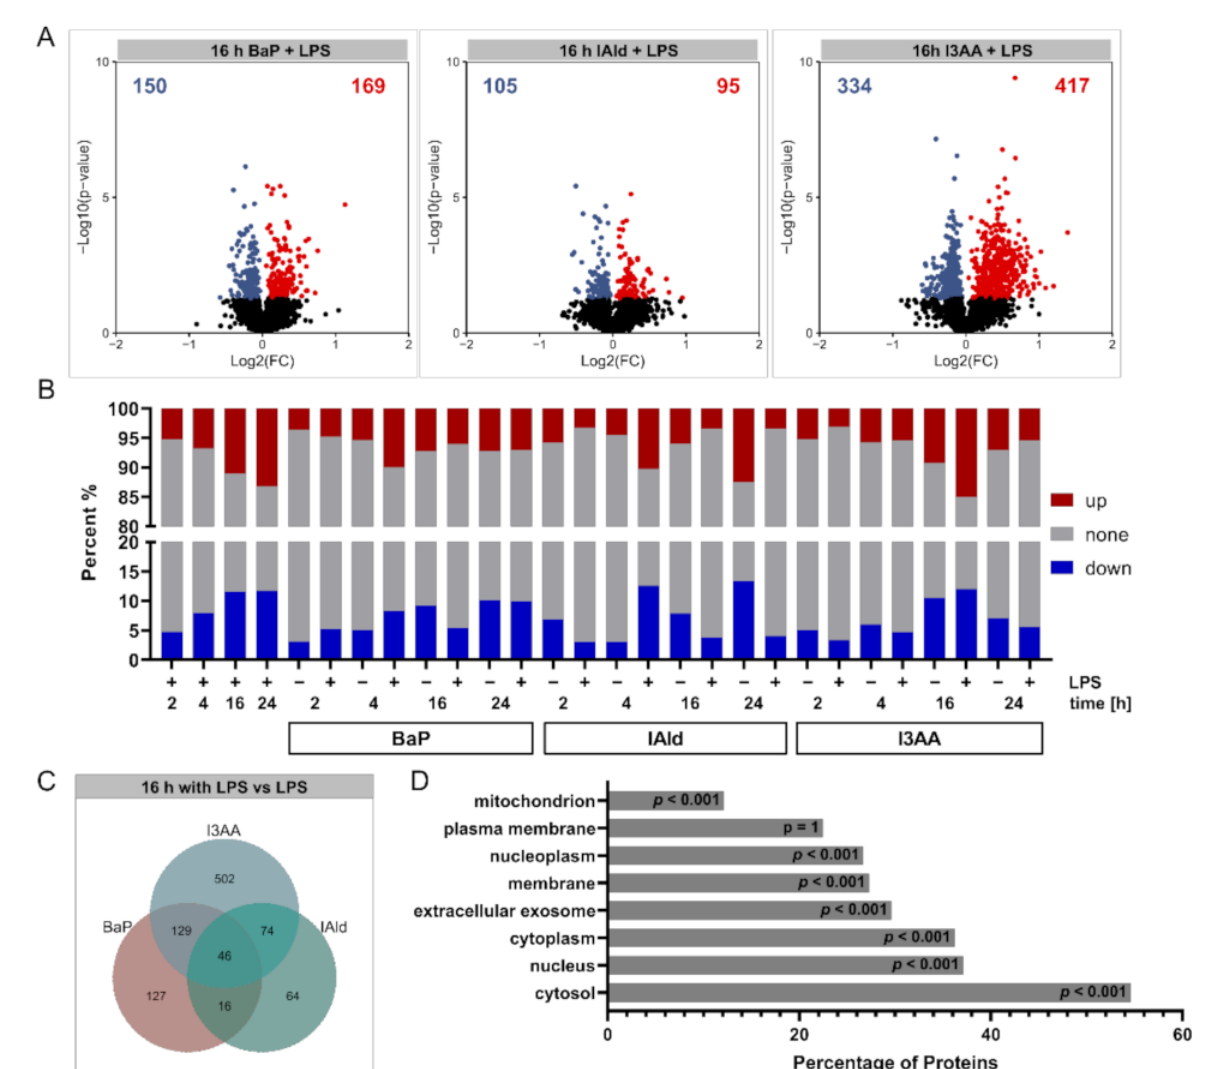
Figure 4. Overview of quantified and regulated proteins. ( A ) Summary of obtained Log2(FCs) and –Log10 ( p -values) after 16 h of BaP, IAld, or I3AA co-stimulated with LPS compared with the LPS control. Significantly altered proteins were highlighted either blue ( p ≤ 0.05, Log2 FC < 0) or red ( p ≤ 0.05, Log2 FC > 0) ( n = 5). ( B ) Percentages of regulated proteins for all investigated comparisons. Down-regulated fractions ( p ≤ 0.05, Log2 FC < 0) are shown in blue and up-regulated fractions ( p ≤ 0.05, Log2 FC > 0) in red for each treatment. ( C ) Overlap of regulated proteins upon co-stimulation with BaP, IAld, or I3AA and LPS after 16 h compared with the LPS control is depicted. ( D ) Mapping of cellular localizations to quantified proteins. Shown are fractions of identified proteins annotated for specific cellular localizations. Significance was calculated by hypergeometric testing with subsequent adjustment for multiple testing, according to Benjamini and Hochberg. Significance of enrichment is